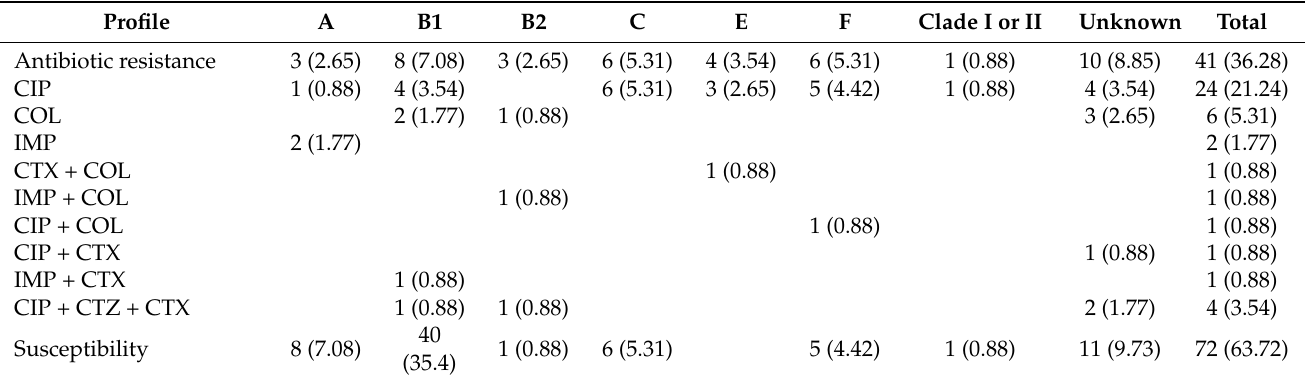
Table 5. Associations between the antibiotic susceptibility and antibiotic resistance genes of E. coli and Phylogenetic Group (B1 and Non-B1).